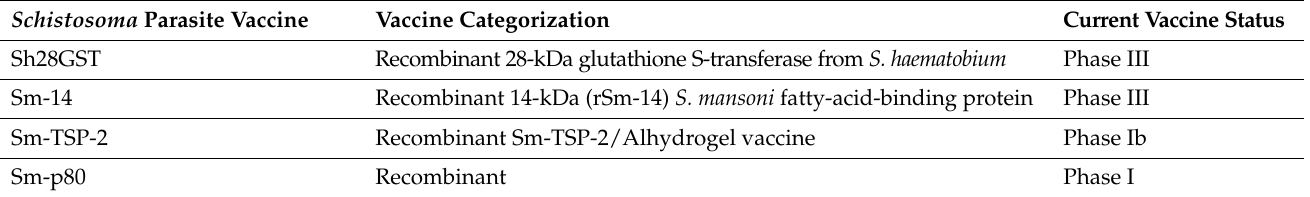
Table 2. Schistosomiasis vaccine development and current